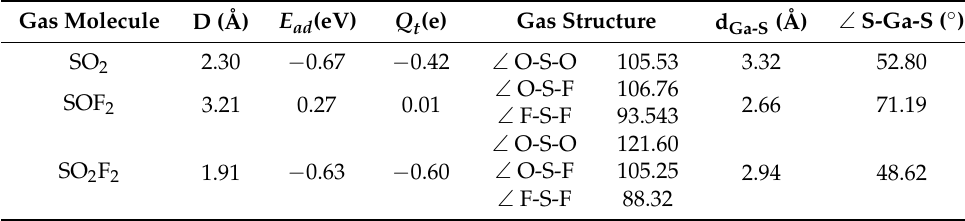
Table 5. The parameters for the target gases on the Ga-MoS 2